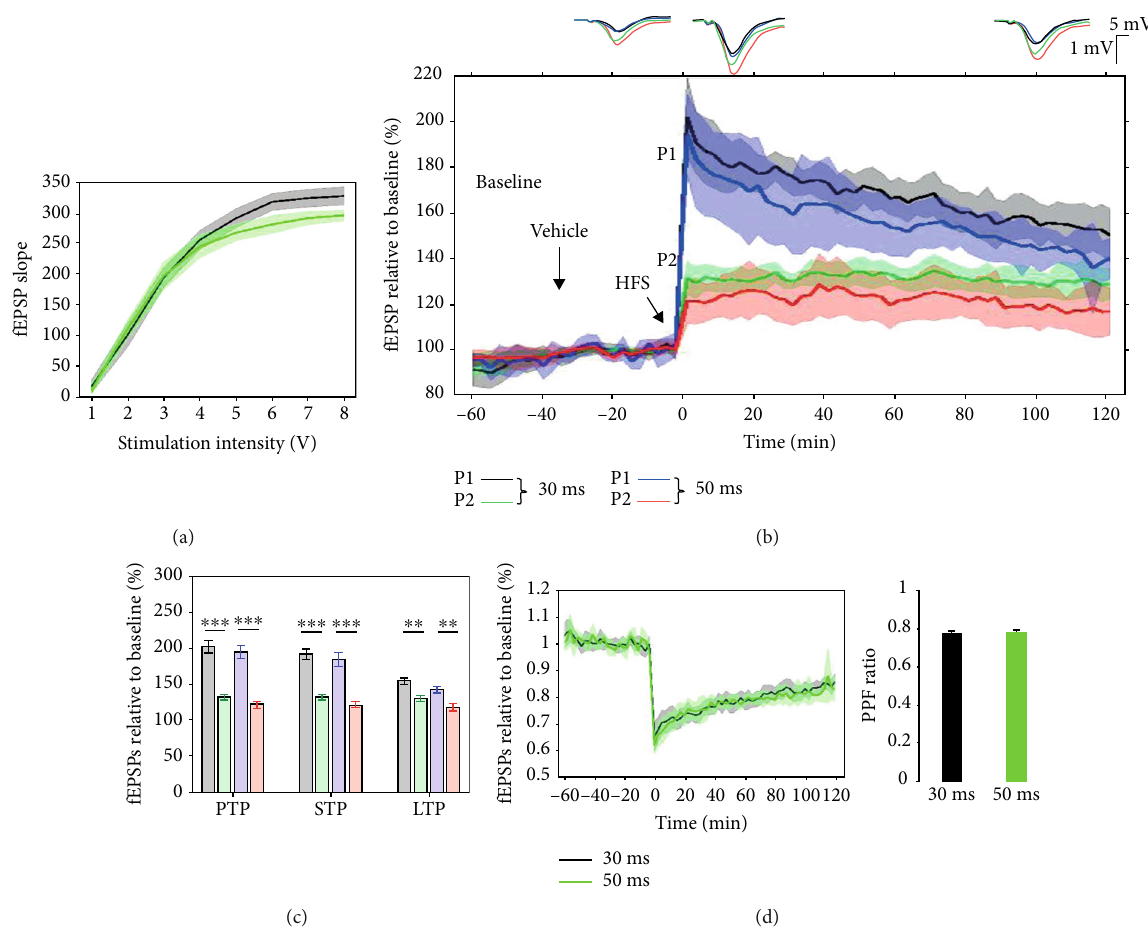
Figure 7: There was no signi fi cant di ff erence in the paired-pulse ratio (PPR) using both 50ms and 30ms interstimulus intervals (ISIs) for the PPF protocol. (a) Collective input/output curves between stimulation voltage and fEPSP slope show no signi fi cant di ff erence in basal synaptic excitability between 0 and 5 V. (b) fEPSP slope relative to baseline for both the fi rst and second responses of both 50 ms ( n = 11 ) and 30 ms ( n = 6 ) interstimulus intervals show a similar response; the second response (P2) for both is lower than the fi rst response (P1), and there is no signi fi cant di ff erence between using 50ms and 30 ms ISIs. Values represent averages ± 95 % confidence intervals . Outsets above LTP curves represent average waveform fi eld potentials during 30min baseline prior to tetanisation and 0-30min and 90-120min posttetanisation. Horizontal bar: 1mV; vertical bar: 5ms. (c) PTP, STP, and LTP responses are presented as means ± 95 % confidence intervals ; ∗∗ p value < 0 : 01 and ∗∗∗ p value < 0 : 001 . (d) The curve shows the normalized ratios of the second and fi rst fi eld potential slopes evoked by paired-pulse stimulation with 30 and 50ms intervals for all groups. Average PPRs show no signi fi cant di ff erence. Right bar plot shows no signi fi cant di ff erence in the average PPRs for 2-hour